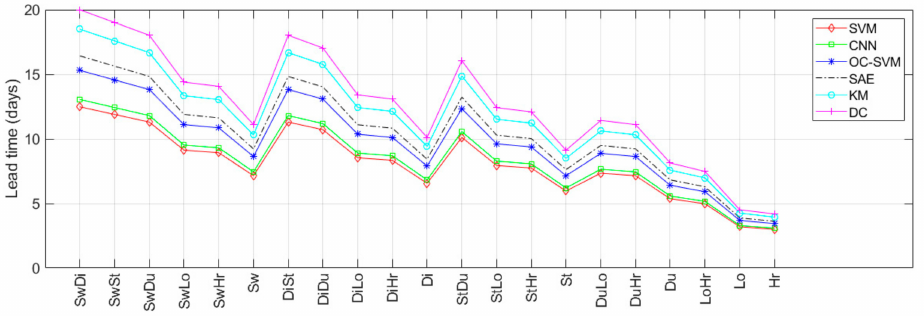
Figure 16. Lead-time of prediction of all compared